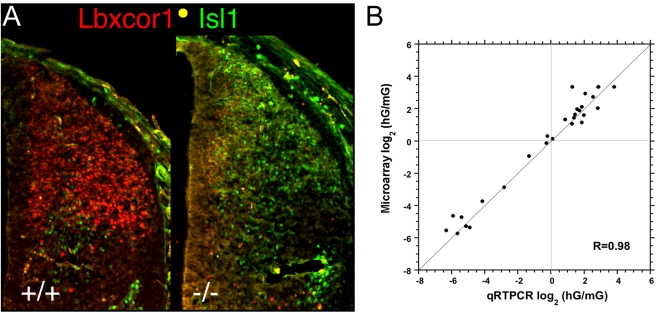
Validation of Microarray Measurements.A) Effect of Lbx1 mutation on Lbxcor1 and Isl1 expression in the thoracic neural tube at E12.5 B) Average fold change observed between hG and mG population pools in three replicate microarrays is plotted against the average fold change measured by quantitative real time PCR (qRTPCR) in at least four replicates. No genes were culled from the initially selected set of 26 genes. Gene regions amplified in qRTPCR generally differed from gene regions detected by Affymetrix probe sets. The outlier in the top right quadrant corresponds to Mafa, which gave erroneous low values in qRTPCR because the crossing thresholds occurred after more than 30 cycles. R = 0.99 if this point is disregarded.